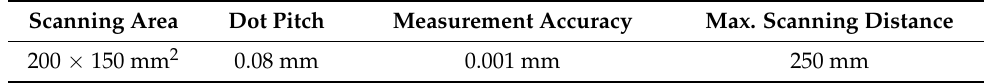
Table 5. Specifications of optical 3D